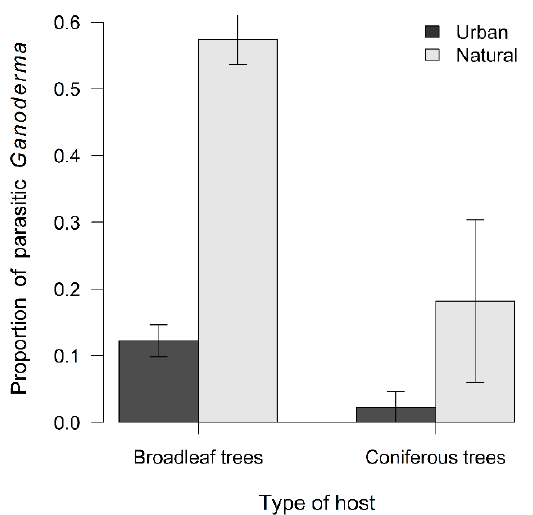
Figure 8. Proportion of parasitic Ganoderma samples in urban or natural environment and on broadleaf or coniferous trees (mean ± SE).